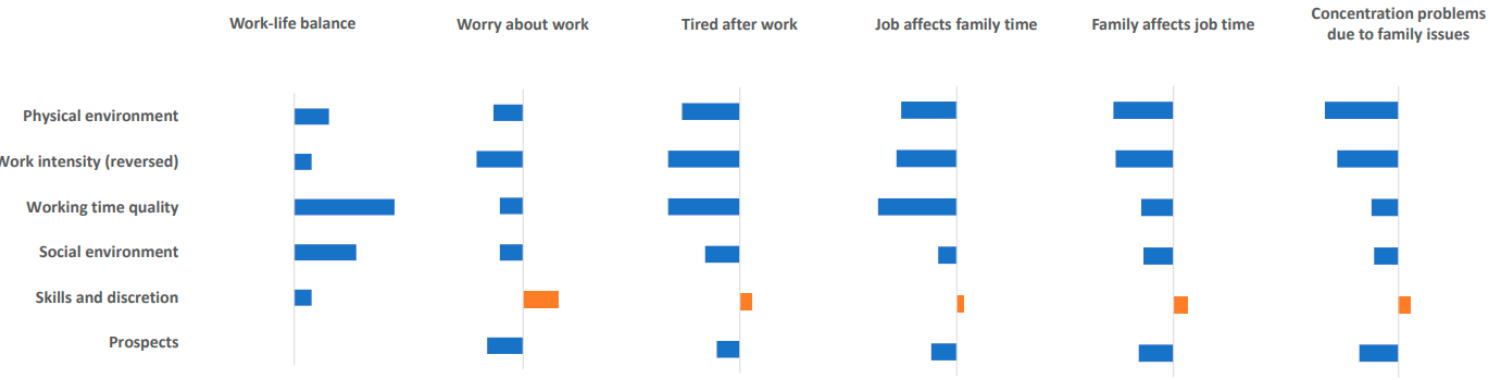
Figure 1. Association between job quality indices and work–life balance (Male).